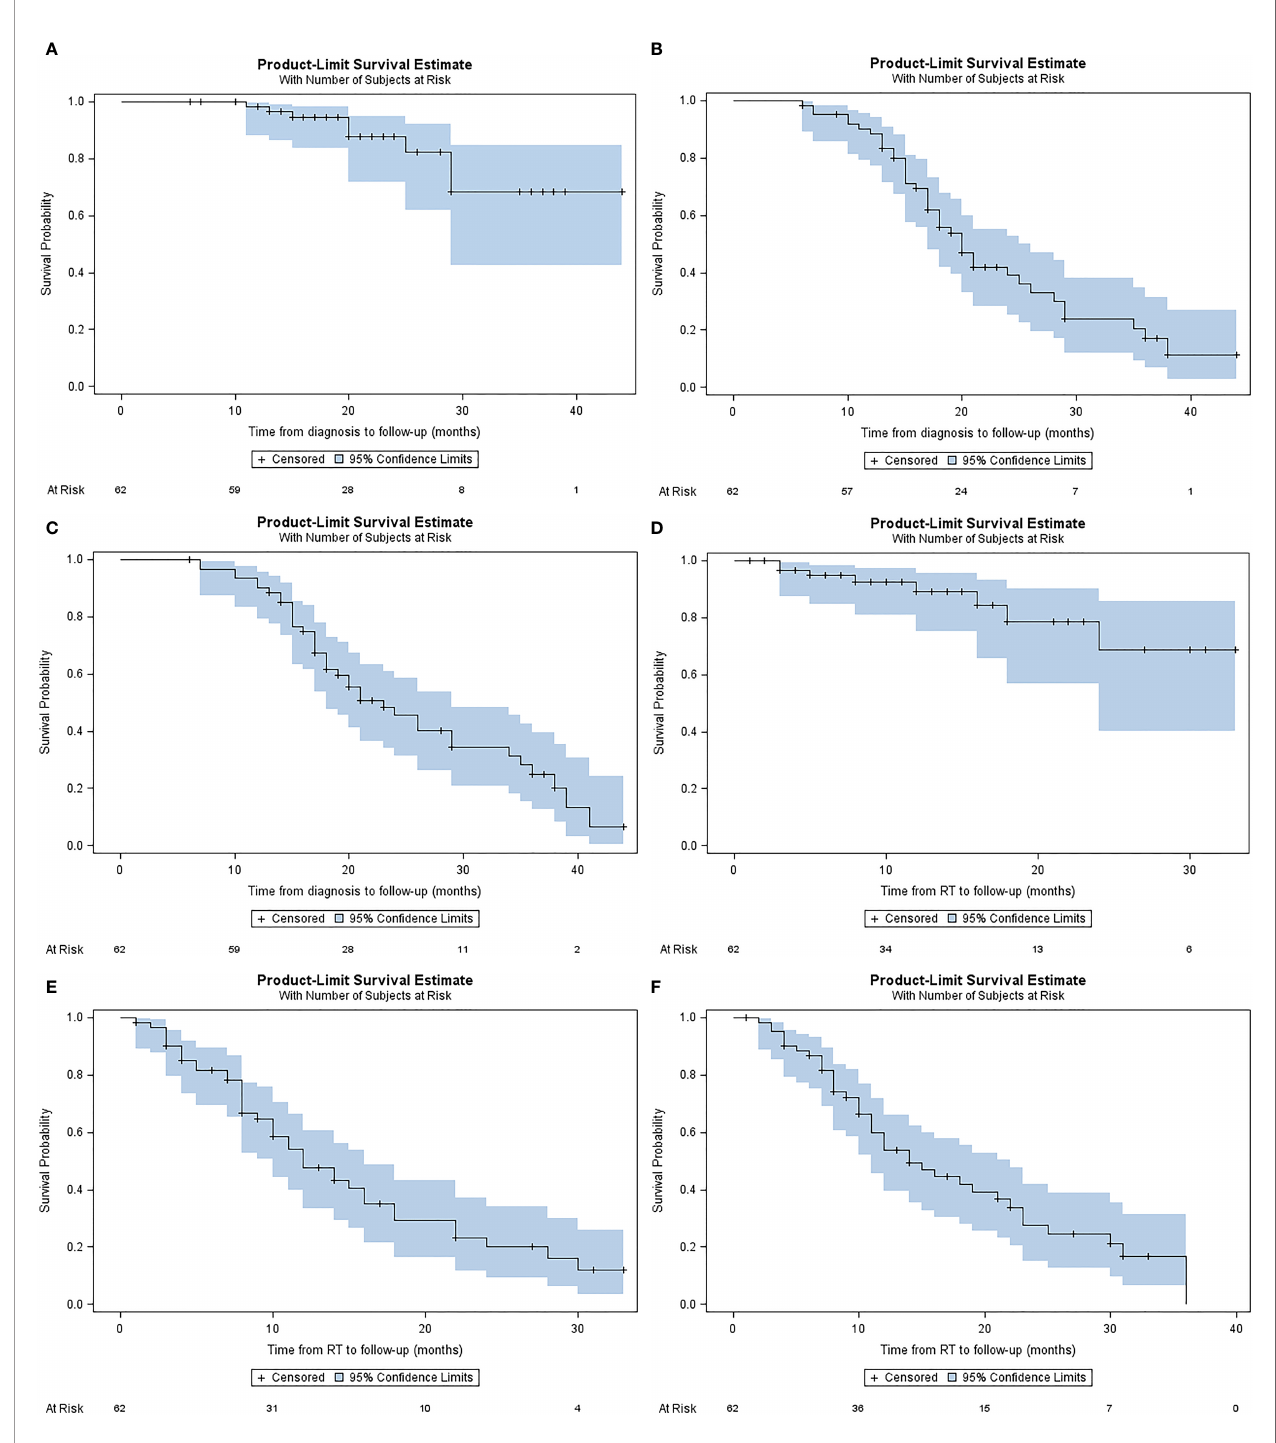
FIGURE 3 | Kaplan-Meier plots describing estimated (A) local control from diagnosis, (B) progression free survival from diagnosis (C) overall survival from diagnosis, (D) local control from A-SMART, (E) progression free survival from A-SMART, (F) overall survival from